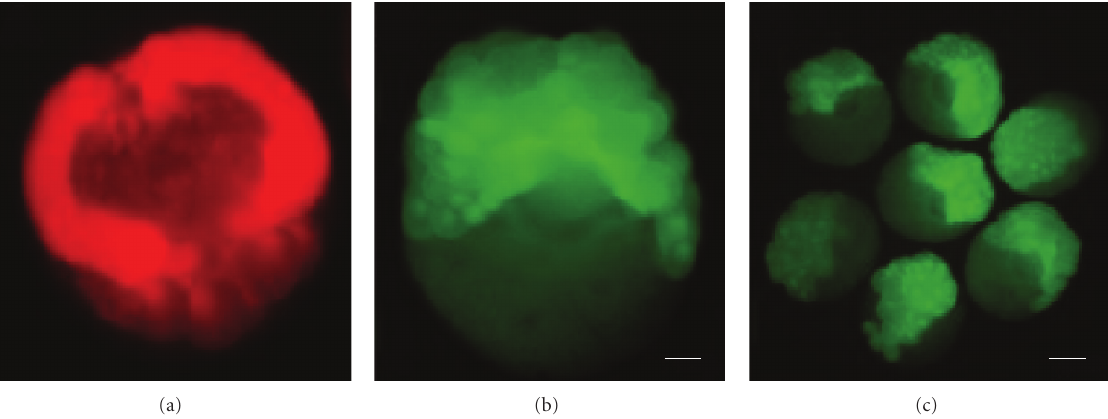
Figure 4: Proliferated cell clusters generated after microinjecting Tpr antisense oligonucleotides into developing Theromyzon tessulatum embryos. (a) Normal, mid-stage 8 embryo fixed ∼ 48 hours after coinjecting sense oligonucleotide TprC and RDA (red) into the D macromere. (b) Representative embryo fixed ∼ 48 hours after co-injecting antisense oligonucleotide TprB and FDA (green) into the D macromere. (c) Sampling of embryos from the same experimental group as in (b). Scale bar = 100 μ m (a), (b); 250 μ m